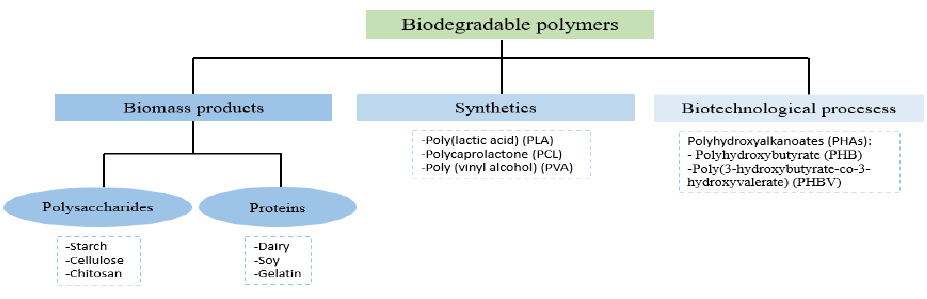
Figure 1. Classification of biodegradable polymers according to their origin. Table 1. Different studies on antimicrobial starch-based